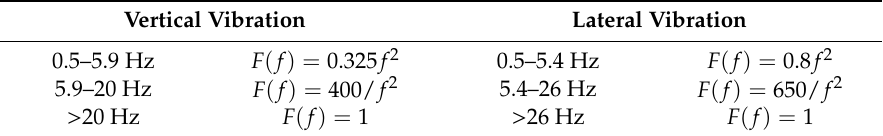
Table 3. Frequency correction factor.